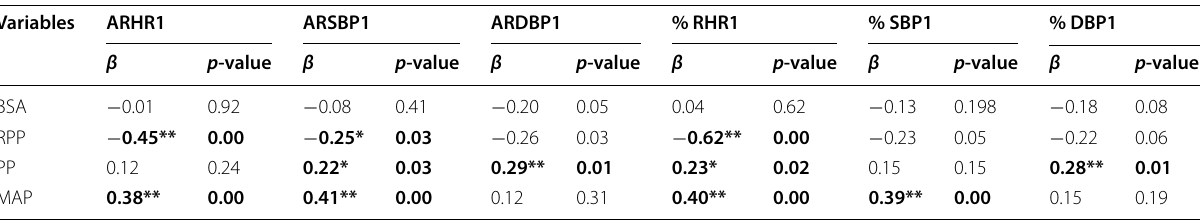
Table 5 Influence of derived indexes on heart rate/blood pressure